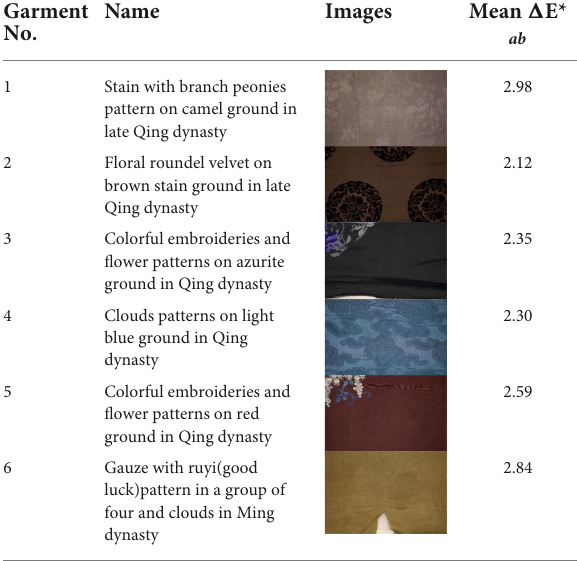
TABLE 2 The results of color prediction accuracy of the six silk fabric garments. Garment